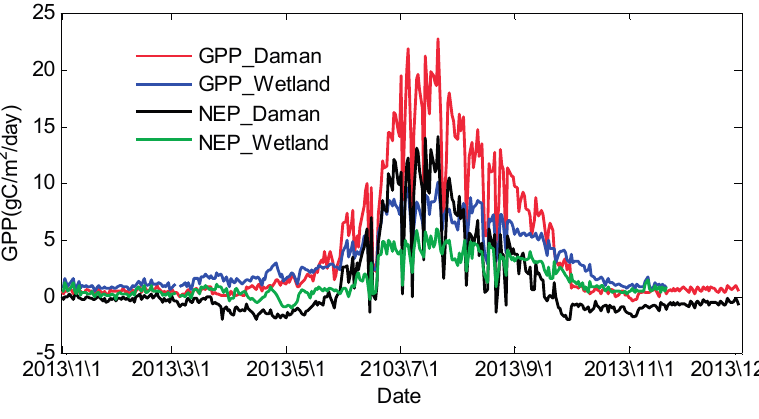
Figure 3. Seasonal dynamics of the GPP and NEP at the Daman superstation and Zhangye wetland